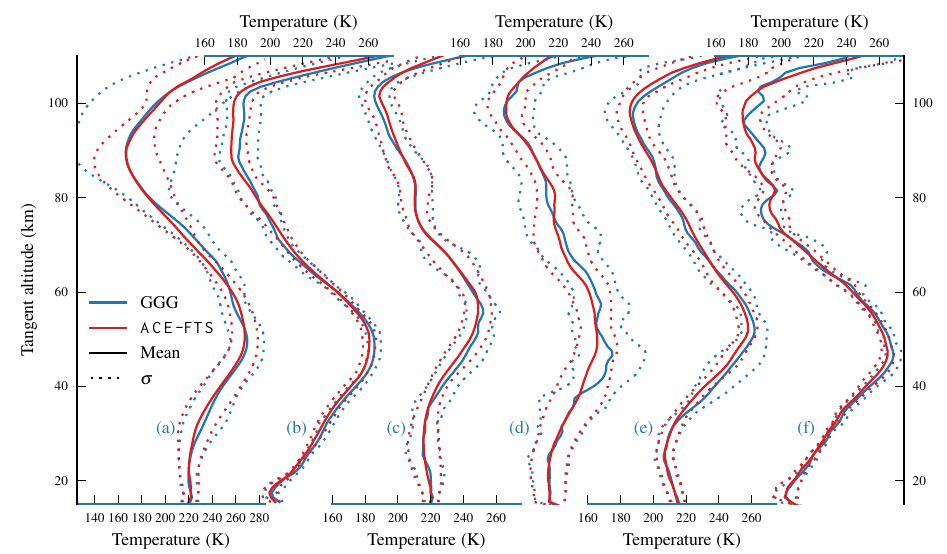
Figure 4. Mean T profiles for each set of occultations in Table 2: (a) Arctic 2010, (b) Middle East, (c) Arctic fall, (d) Arctic winter, (e) Antarctic spring, and (f) low latitudes. Solid lines are mean T profiles for each set, and dashed lines are ± their respective standard deviations. The blue lines represent retrieved T profiles from GGG and the red lines represent ACE-FTS v3.5 retrievals. Means are computed on the 1km interpolated grid; see Table 2 for the number of occultations in each set.